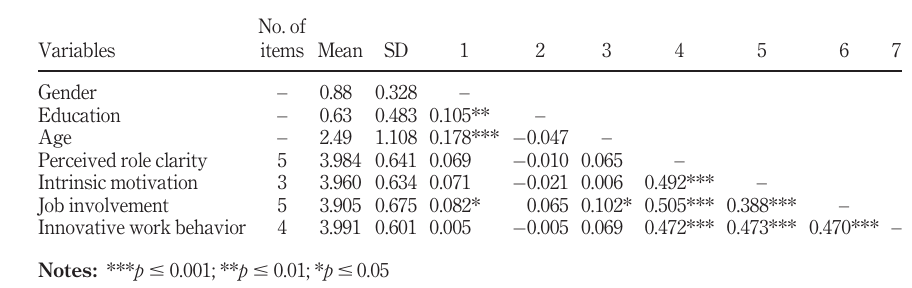
Table III. Means, standard deviations and